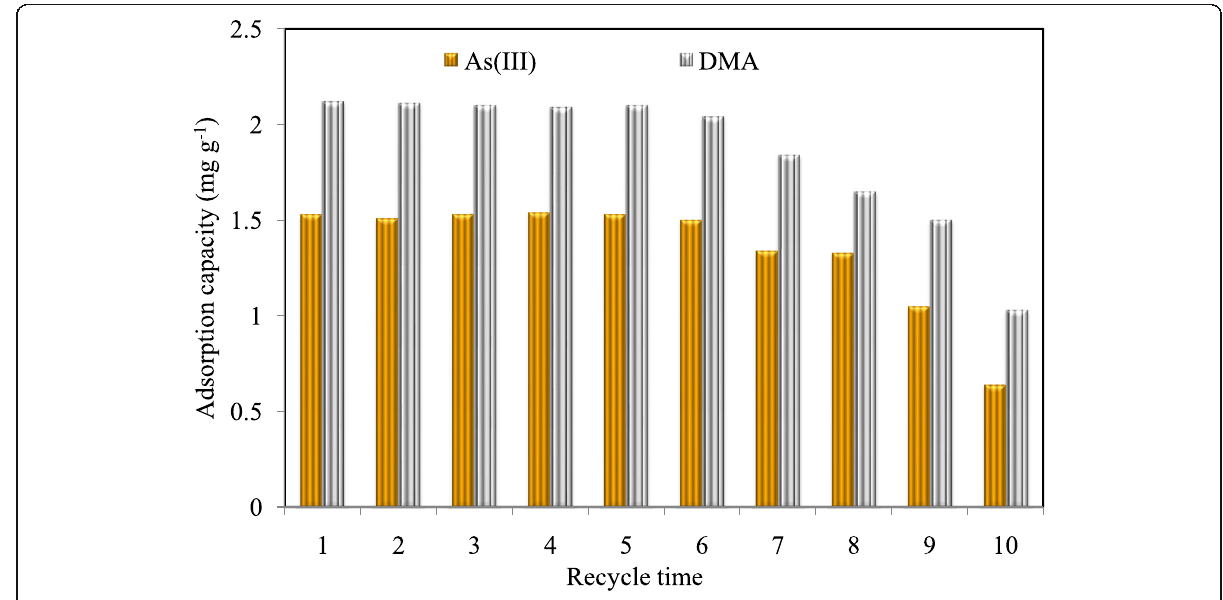
Fig. 6 The uptake of arsenic by biochar in consecutive adsorption-desorption